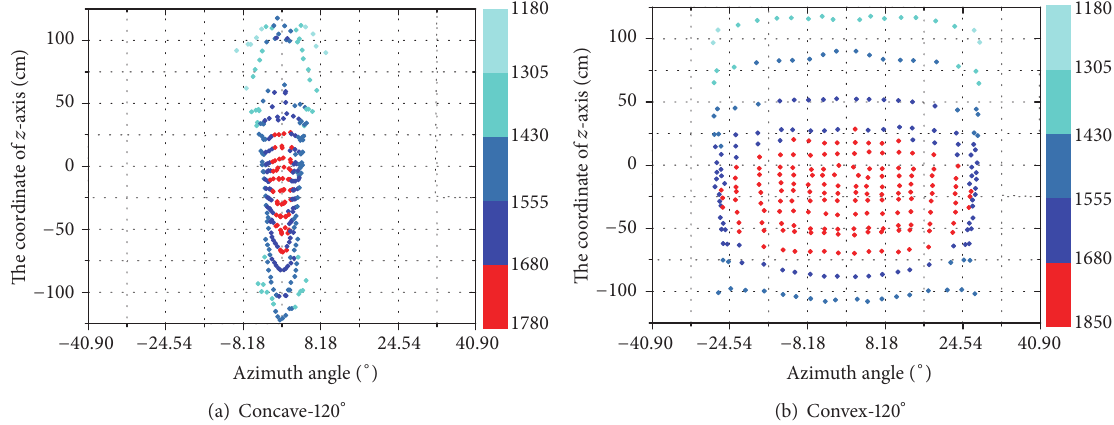
Figure 7: The distributions of fragments from the